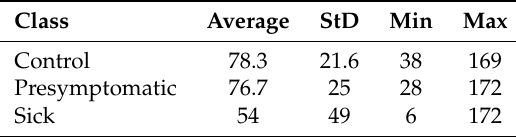
Table 1. Average, standard deviation, minimum and maximum number of saccades per register in the entire data